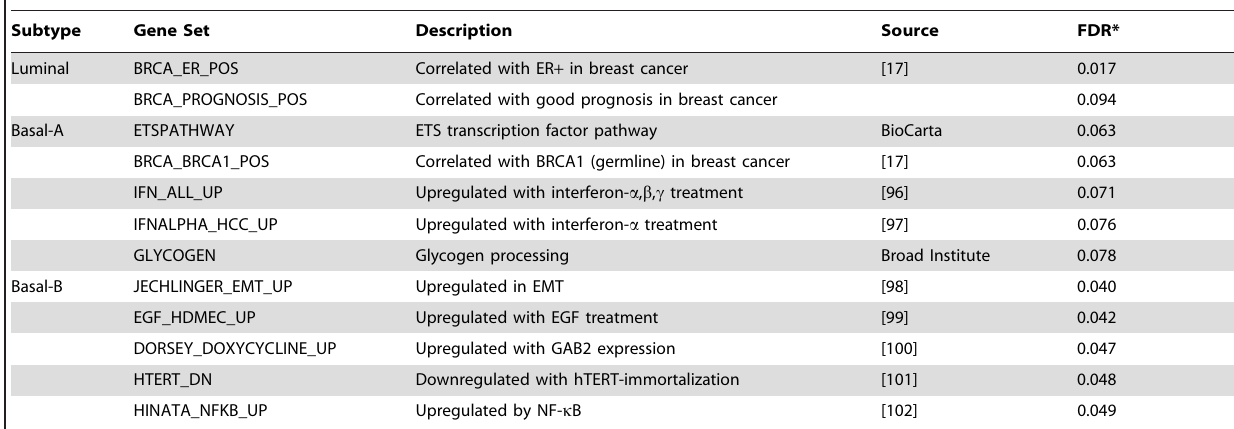
Table 3. GSEA of breast cancer cell line